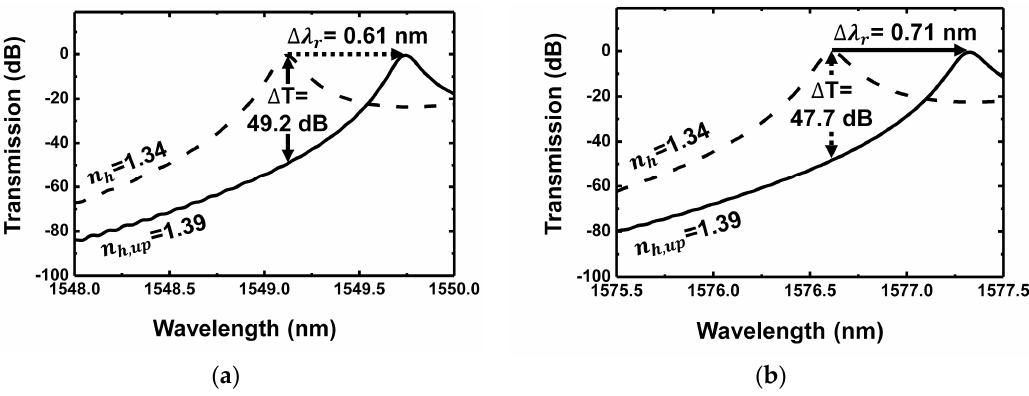
Figure 8. Transmission spectrum by applying the optimized grating waveguide parameters to achieve maximum ( a ) transmission extinction; ( b ) resonance shift before and after bio-interaction detection in the target layer. (Dashed curve: before multivalent binding ( n h = 1.34), solid curve: after multivalent binding ( (cid:1866) (cid:3035),(cid:3048)(cid:3043) = 1.39).